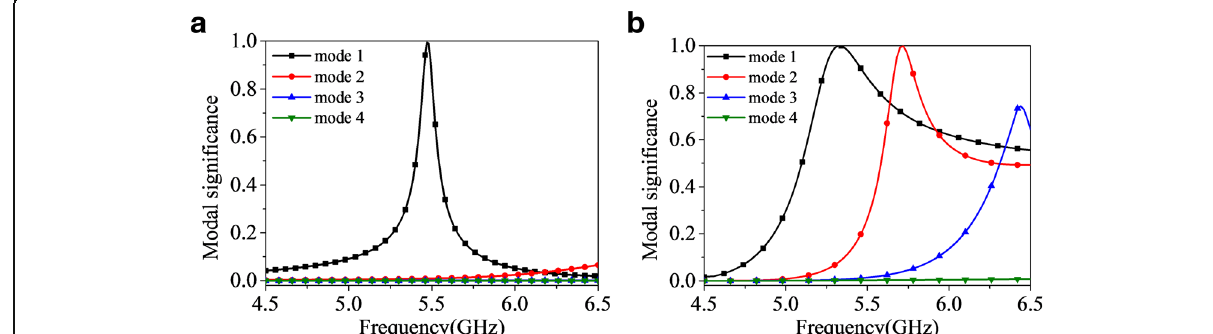
Fig. 4 Modal significance of the anisotropic element with ( a ) and without ( b ) bowtie-shaped